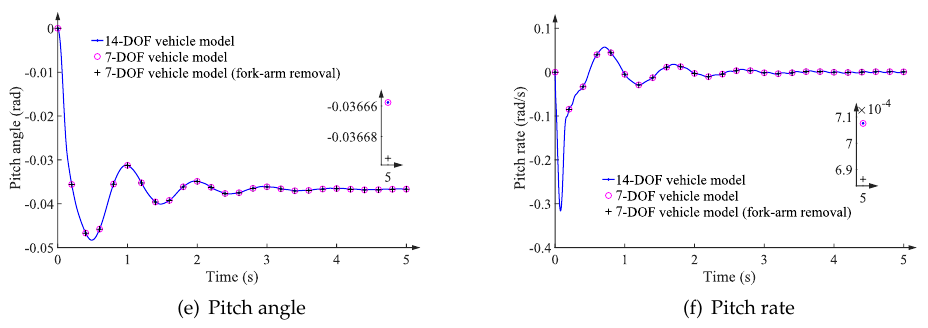
Figure 11. Results on the sloping road with different vehicle models.